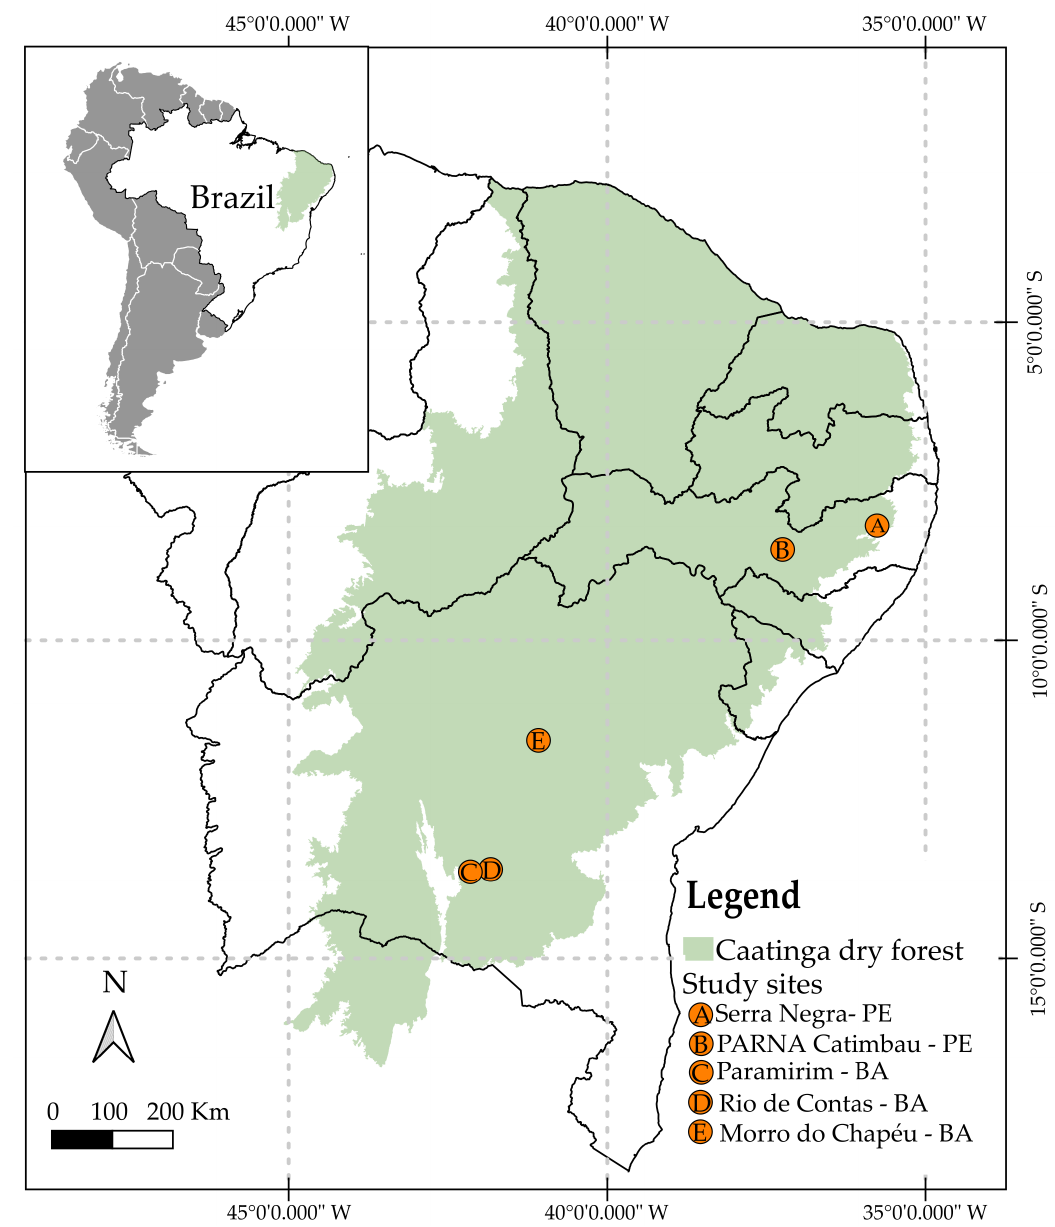
Figure 1. Map indicating the sites of the Cereinae taxa studied. The Caatinga area within Northeastern Brazil is highlighted in green, and the five study sites are represented by orange circles. Note: States of study areas, PE: Pernambuco, BA: Bahia.